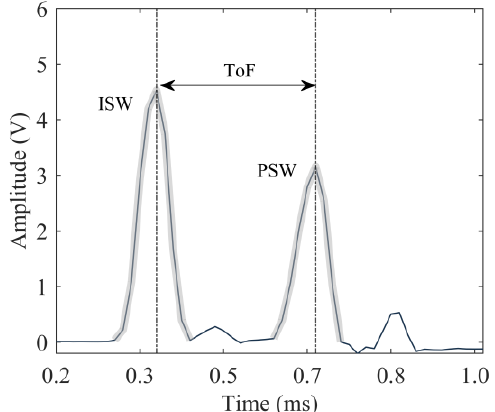
Figure 10. Steel plate test. Example of one of the hundred-time waveforms recorded during the experiment.